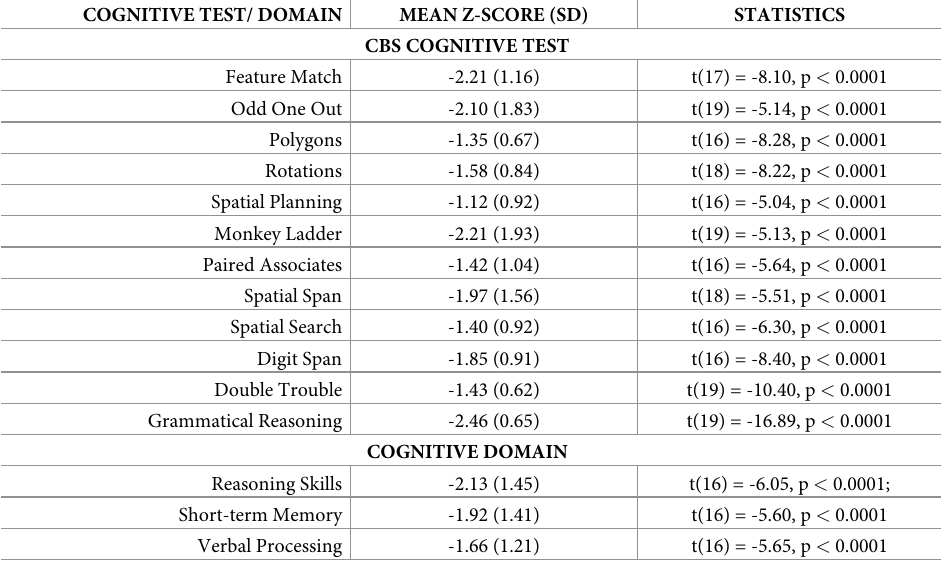
Table 2. Cognitive performance of critical care survivors relative to healthy control